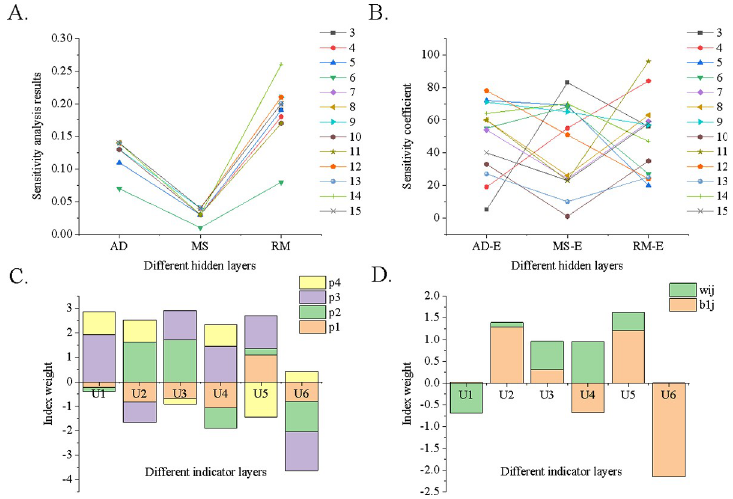
network layers 1–6.